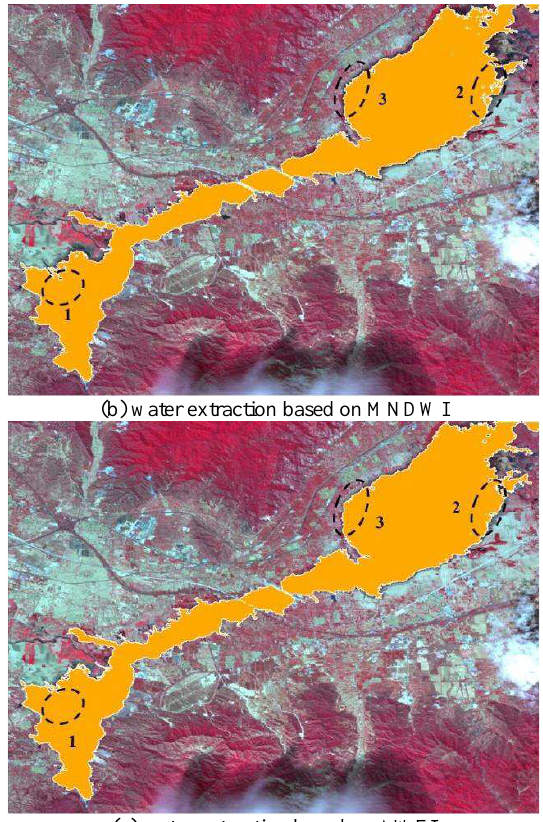
Figure 10. Water Extraction Results for the AHSI image of Guanting